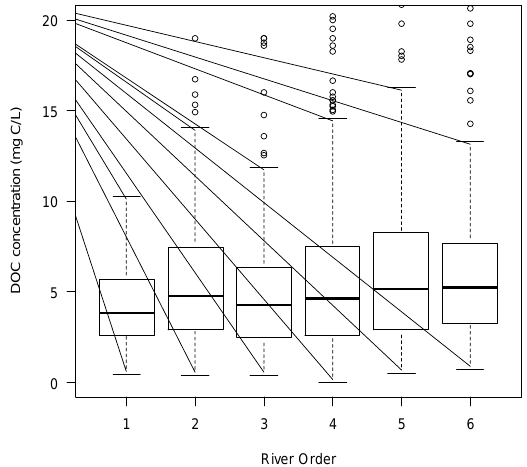
Figure 3. Variation in DOC concentrations by river orders (Order 1: 40 stations; Order 2: 119 stations;